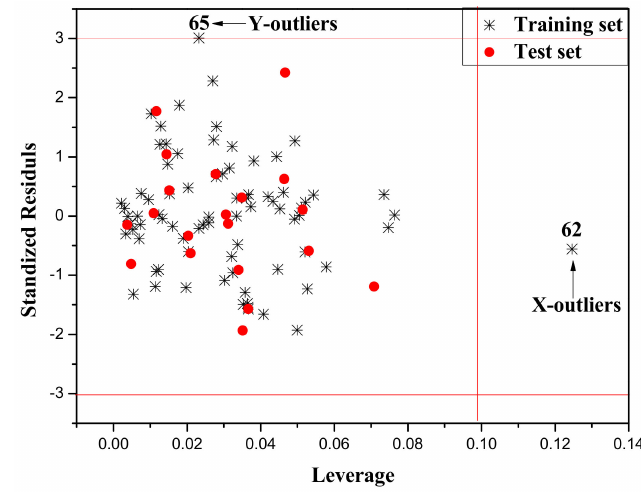
Figure 3. The William plot of the training and external test